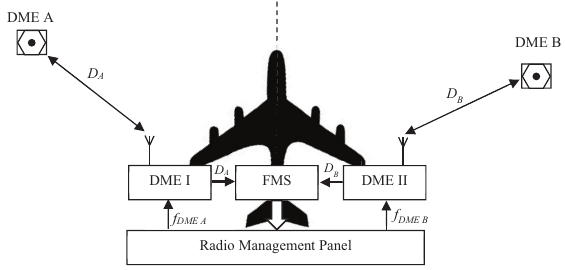
Figure 2. Distance measuring equipment